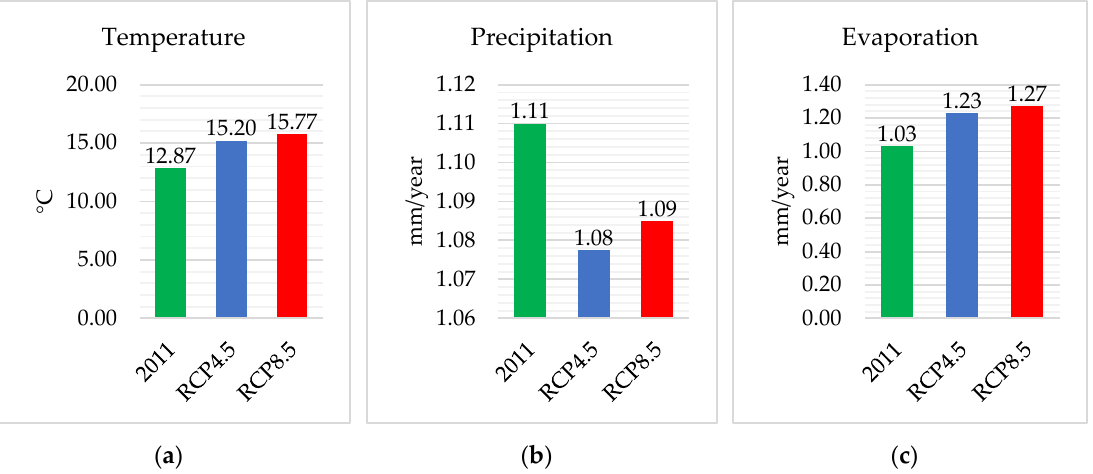
Figure 3. The average ( a ) temperature, ( b ) precipitation, and ( c ) evaporation during 2020–2050 and in 2011.